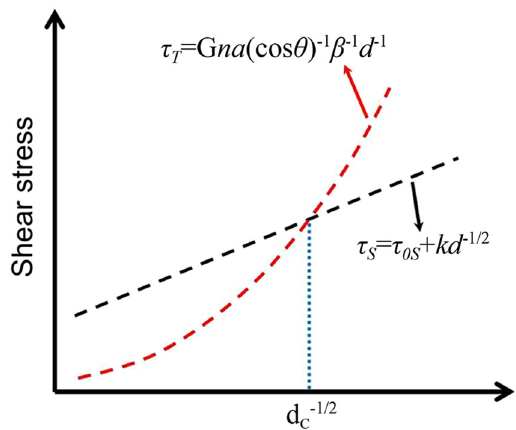
Figure 5. The schematic of relationship for slip shear stress and twin shear stress with grain